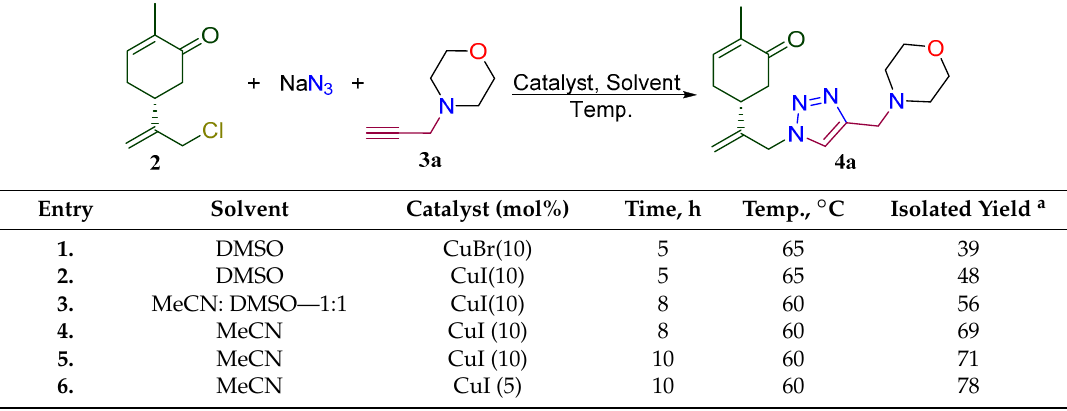
Table 1. Optimization of synthesis of 4a . Table 1. Optimization of synthesis of 4 а . Table 1. Optimization of synthesis of 4 а . Table 1. Optimization of synthesis of 4 а . Table 1. Optimization of synthesis of 4 а . Table 1. Optimization of synthesis of 4 а . Table 1. Optimization of synthesis of 4 а . Table 1. Optimization of synthesis of 4 а . Table 1. Optimization of synthesis of 4 а . Table 1. Optimization of synthesis of 4 а . Table 1. Optimization of synthesis of 4 а .